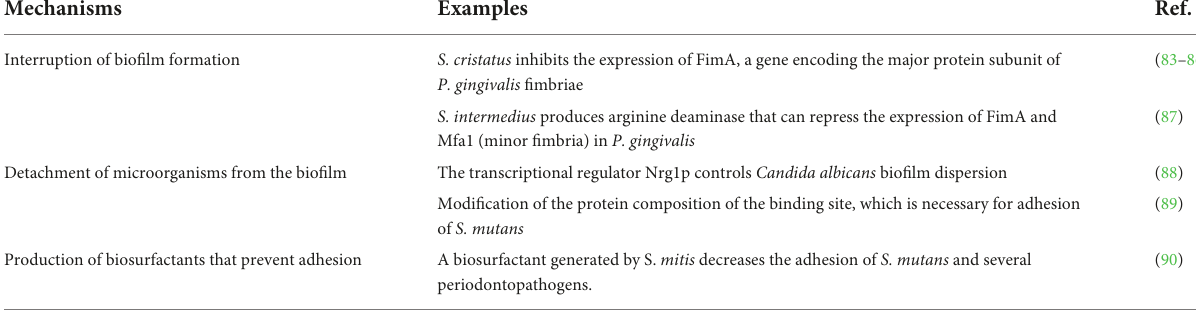
TABLE 2 The mechanisms involved in the competition for attachment sites of colonization resistance. Mechanisms